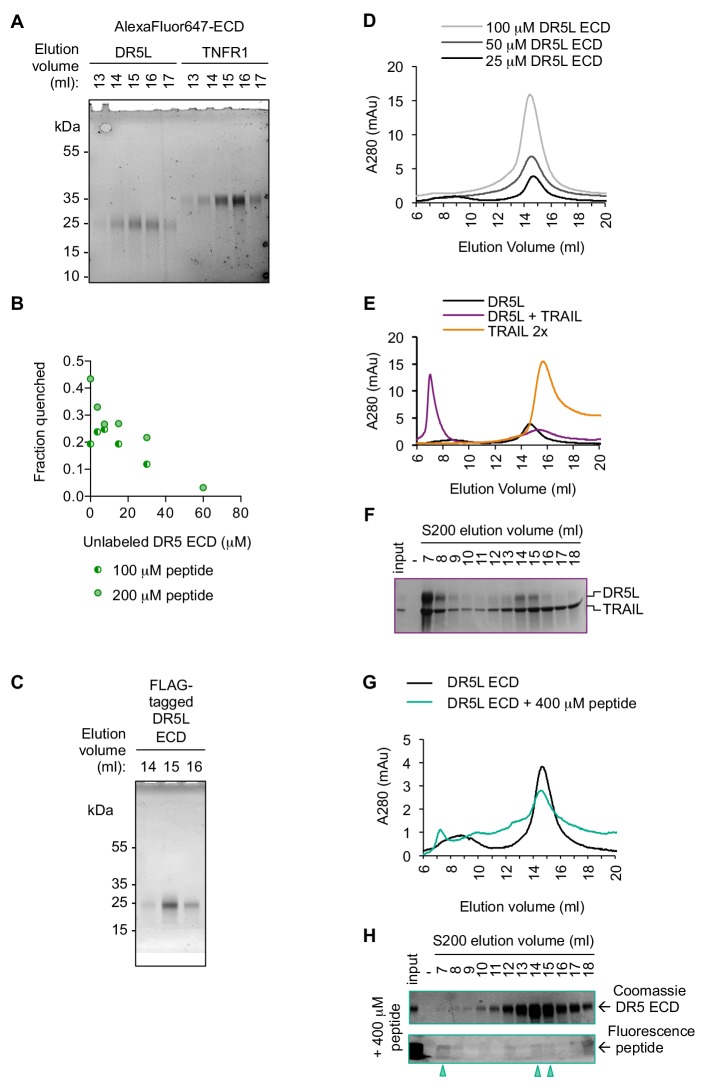
Purified recombinant DR5 ECD oligomerizes with peptide in a specific and reversible manner.(A) Fluorescence scan at 647 nm of SDS-PAGE for gel filtration-purified DR5L (25 kDa) or TNFR1 ECD (35 kDa) labeled with NHS-ester AlexaFluor647. These proteins were used in the fluorescence quenching assays shown in Figure 3C. (B) Fluorescence de-quenching of AlexaFluor647-DR5L ECD (200 nM) pre-incubated with 100 μM or 200 μM of MPZ-ecto peptide in the presence of increasing concentrations of unlabeled DR5L ECD. (C) Coomassie-stained SDS-PAGE of gel filtration purified FLAG-tagged DR5L ECD proteins used for the crosslinking assay in Figure 3D and size exclusion chromatography in Figure 3E. (D) Size exclusion chromatographs of absorbance at 280 nm for recombinant DR5L ECD to show that increased concentration of DR5L alone does not yield multimers. (E) Size exclusion chromatographs of absorbance at 280 nm for recombinant DR5L ECD alone (25 μM, black) or incubated with TRAIL (25 uM, purple). Trace for TRAIL alone (50 μM) is shown in light orange. (F) SDS-PAGE gels stained with Coomassie blue for eluted size exclusion fractions in Figure 3—figure supplement 2E depicting bands for DR5L ECD and TRAIL. (G) Size exclusion chromatographs of absorbance at 280 nm for 25 μM recombinant DR5L ECD alone (black), pre-incubated with 400 μM fluorescein-conjugated MPZ-ecto peptide (teal). (H) SDS-PAGE gels scanned for fluorescence and then stained with Coomassie for eluted size exclusion fractions in Figure 3—figure supplement 2G. Lane marked by “-“ denotes a blank lane between the input and 7 ml fraction to minimize spillover of signal from input sample. Arrowheads mark detectable peptide fluorescence in the indicated fractions.